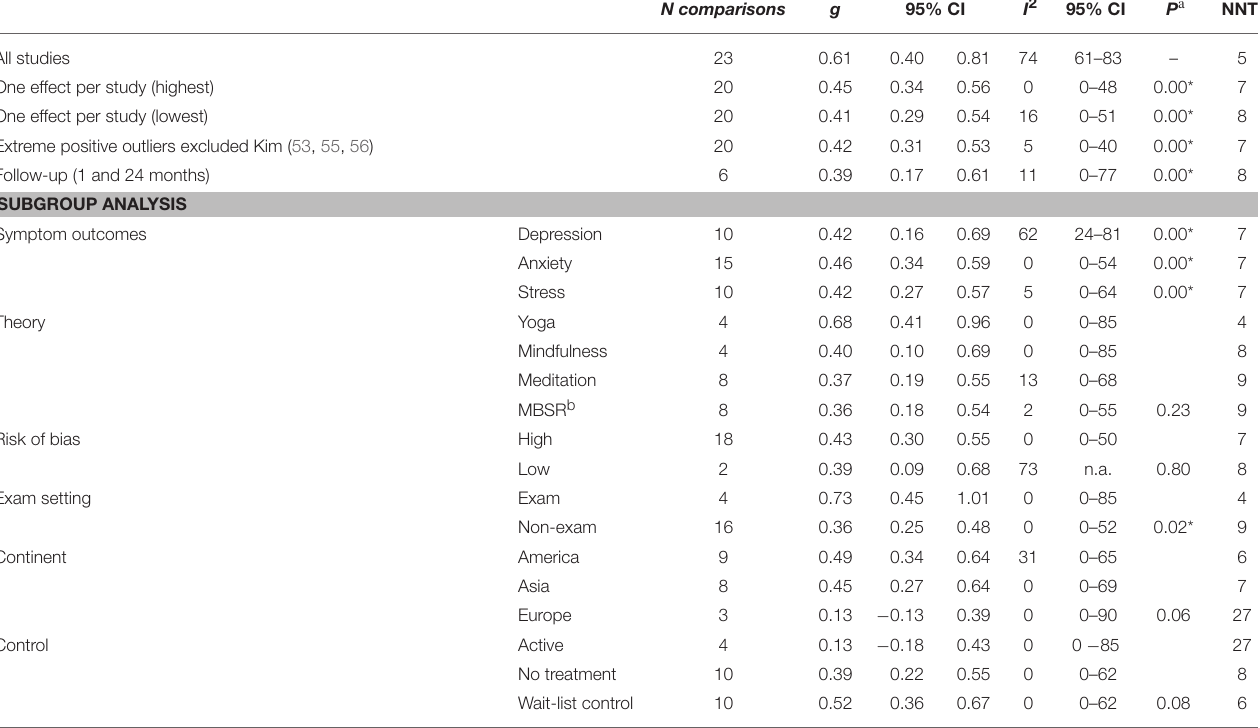
TABLE 4 | Effects of meditation based interventions on depression, anxiety, and stress compared to control with Hedges g .